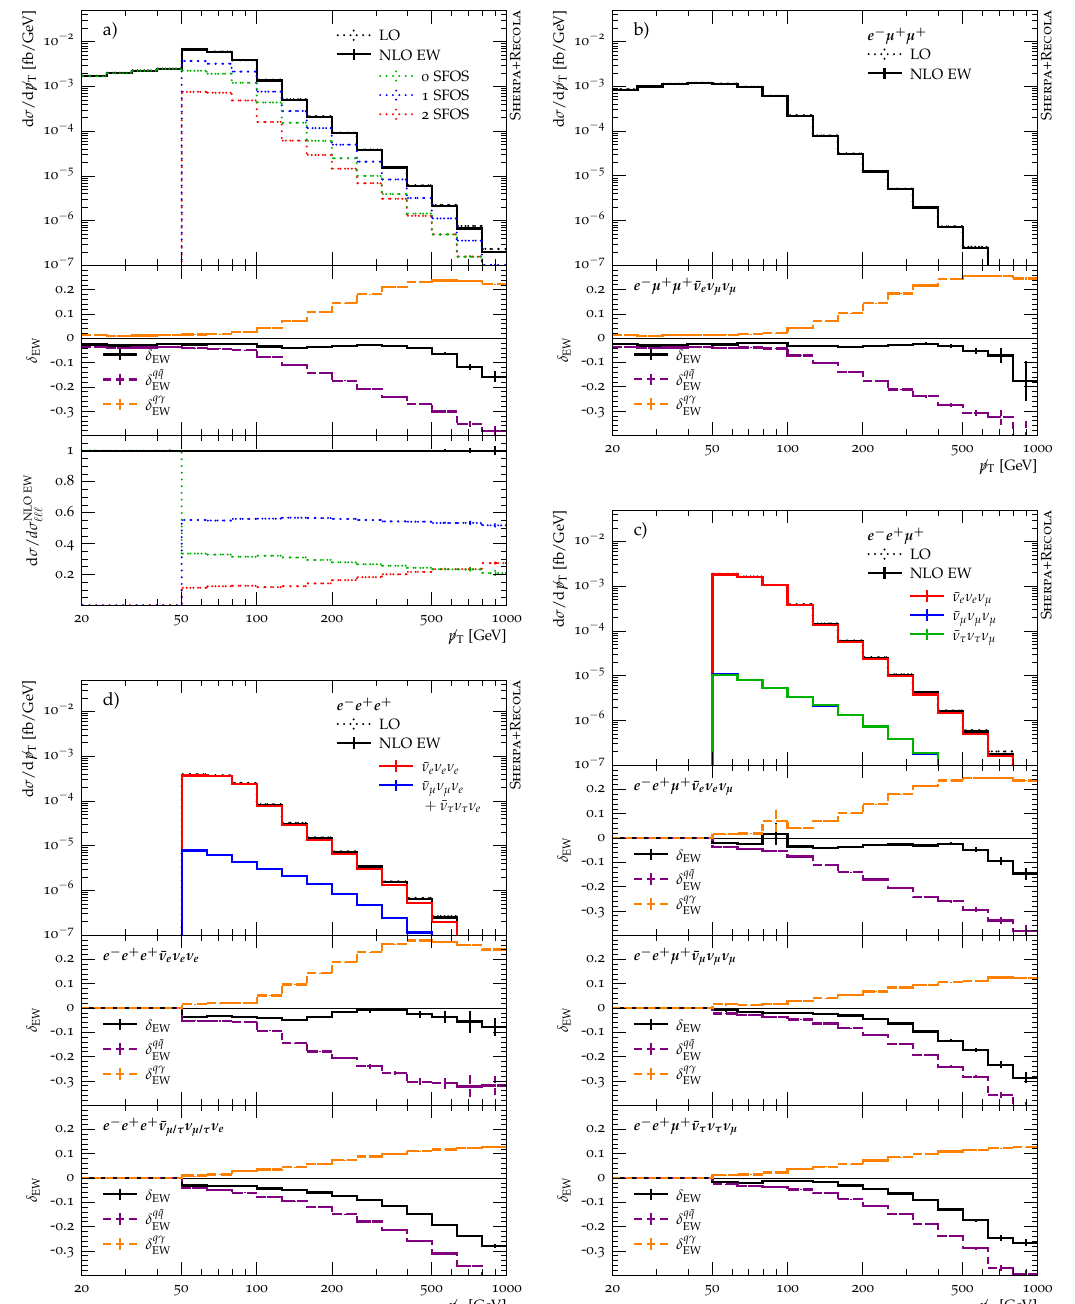
Figure 2 . Electroweak corrections to the missing transverse momentum distribution.